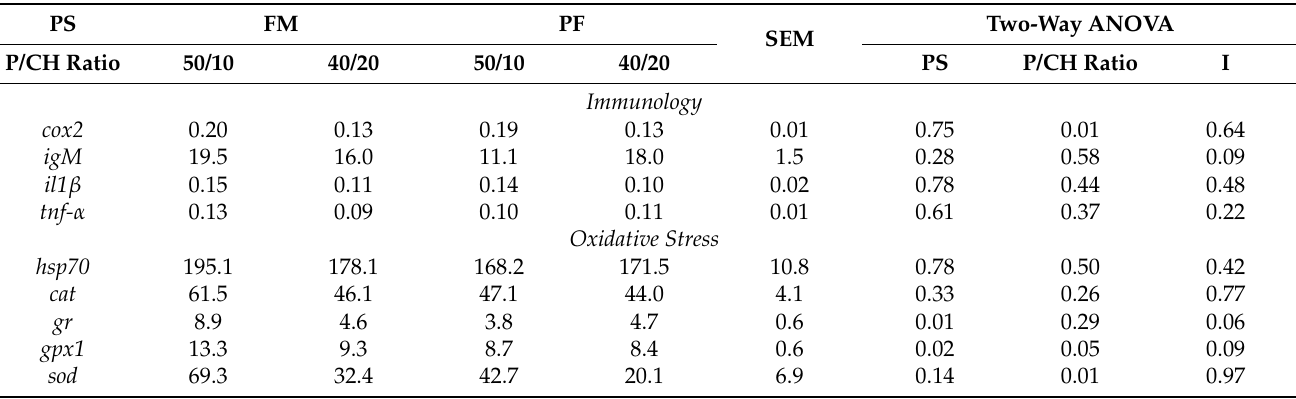
Table 7. Normalized gene expression 1 of immunology and oxidative stress-related genes in midgut of gilthead seabream fed the experimental